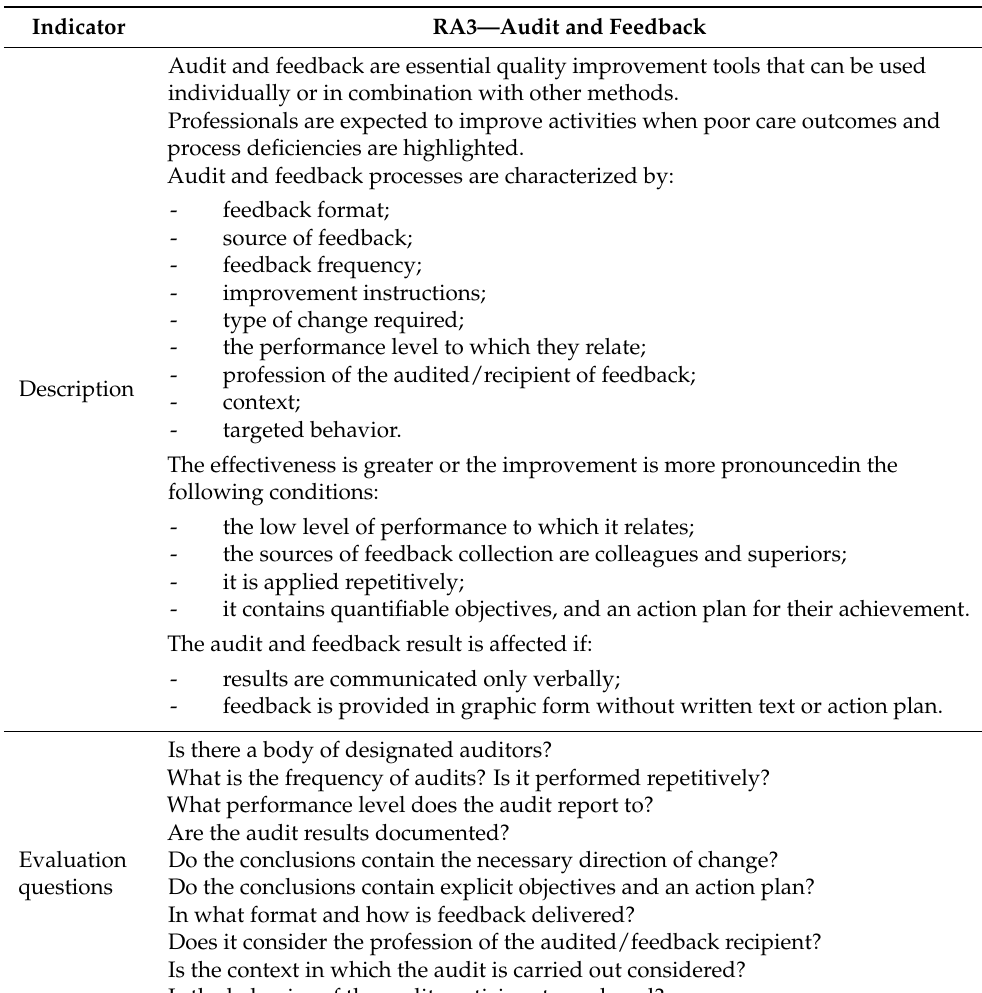
Table A15. The indicator RA3—Audit and feedback. Indicator RA3—Audit and